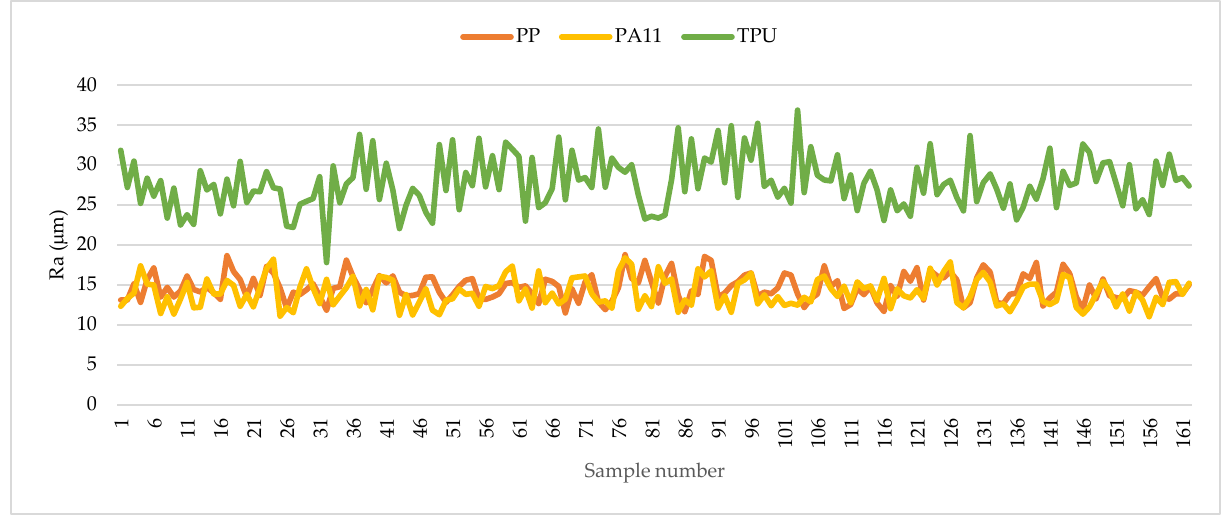
Figure 11. The average roughness profile deviation ( 𝑅 𝑎 ) for all of the samples. Figure 12 shows the averaged-out values of 𝑅 𝑎 for the respective print chambers (including all six orientations). The highest nine values in the print chamber are marked in red, and the lowest nine values are marked in green. The intermediate values are highlighted in yellow.